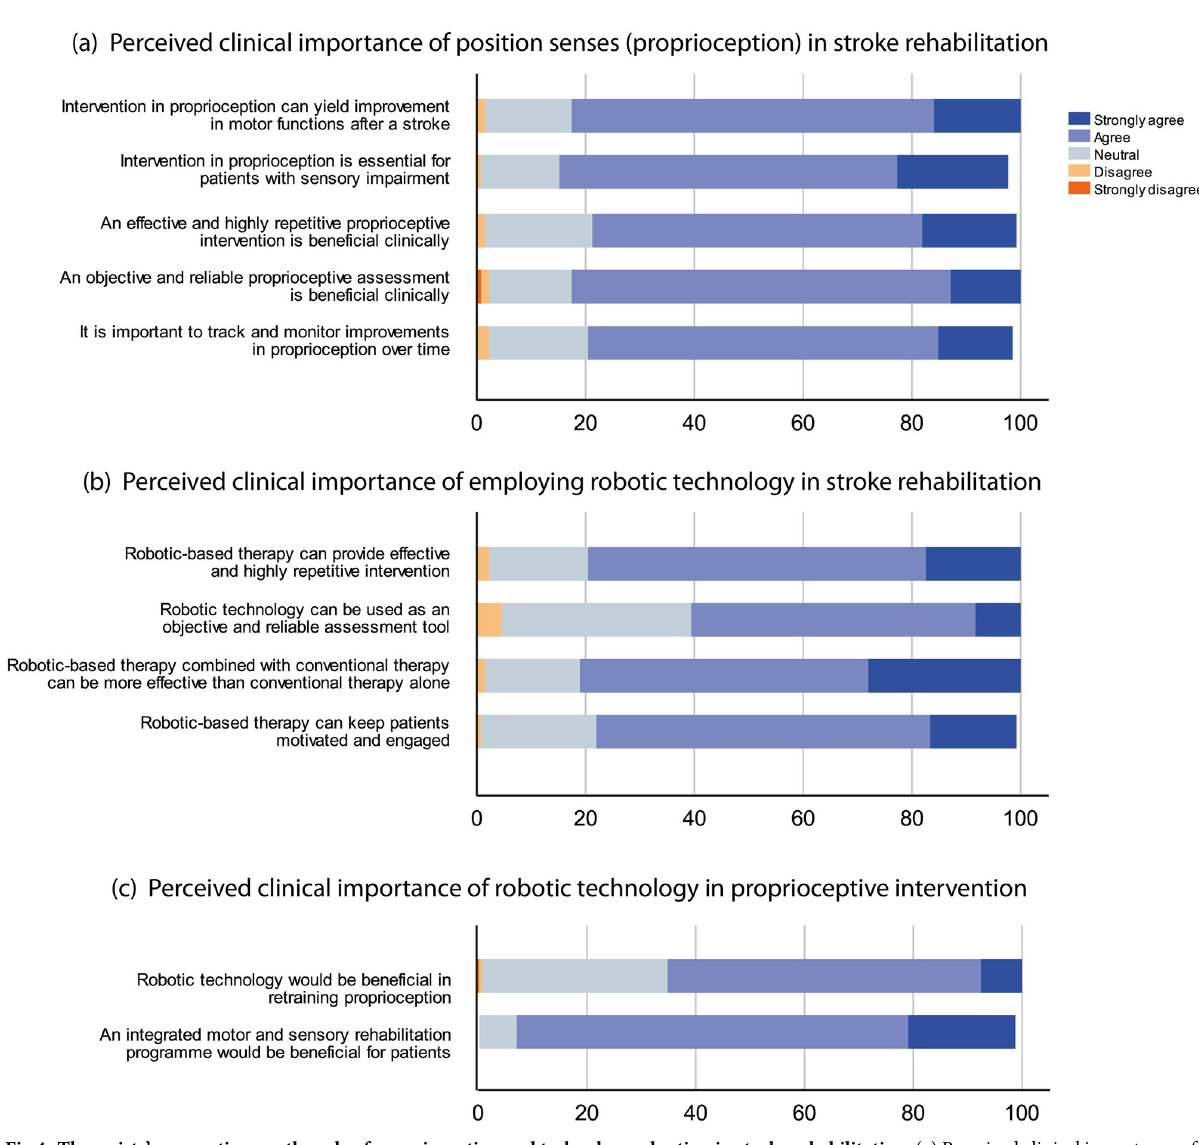
Fig 4. Therapists’ perspectives on the role of proprioception and technology adoption in stroke rehabilitation. (a) Perceived clinical importance of proprioception . (b) Perceived clinical importance of robotic technology. (c) Perceived clinical importance of adopting robotic technology specifically for proprioception.